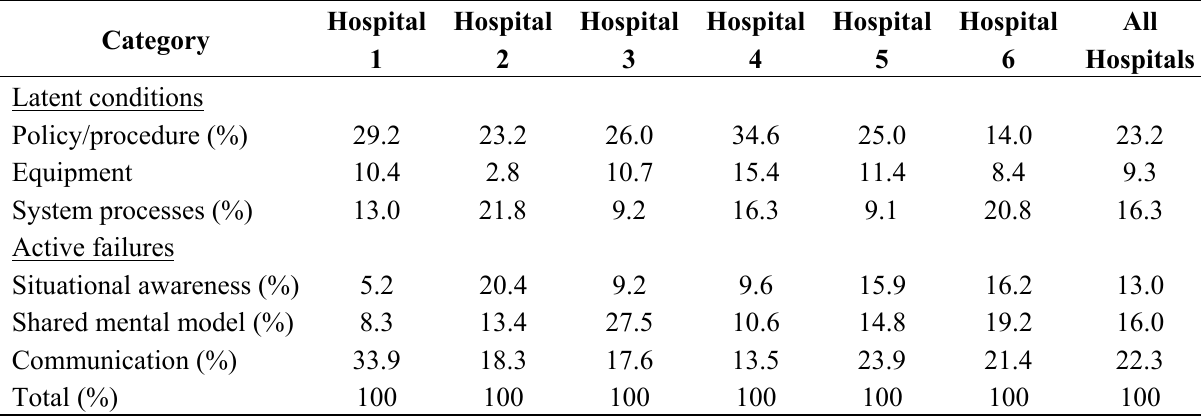
Table 10. Relative proportion of breaches by category by hospital